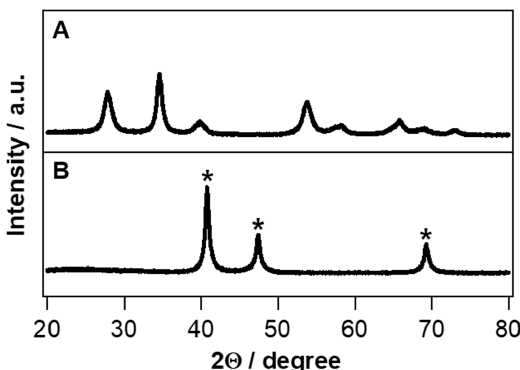
Figure 3. XRD graphs of ( A ) IrO 2 and ( B ) Ir metal nanotubes. The peaks marked with * are XRD peaks of Ir metal, whereas the peaks without any mark are XRD peaks of IrO 2 .